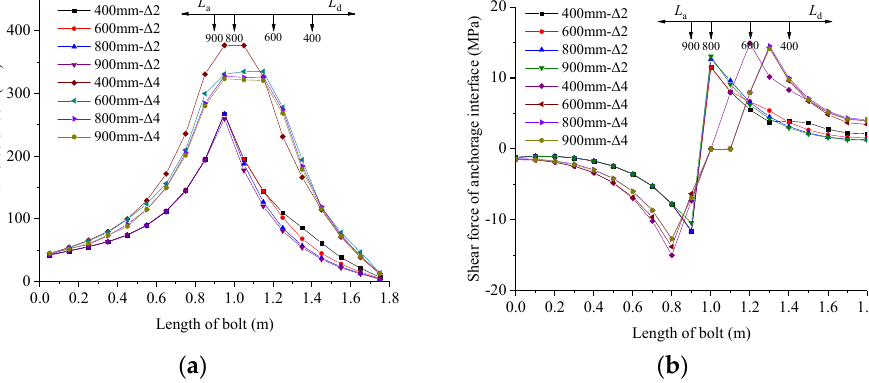
Figure 6. Simulation results of different values of L a. ( a ) Axial force of the bolt. ( b ) Shear force of the anchorage interface.